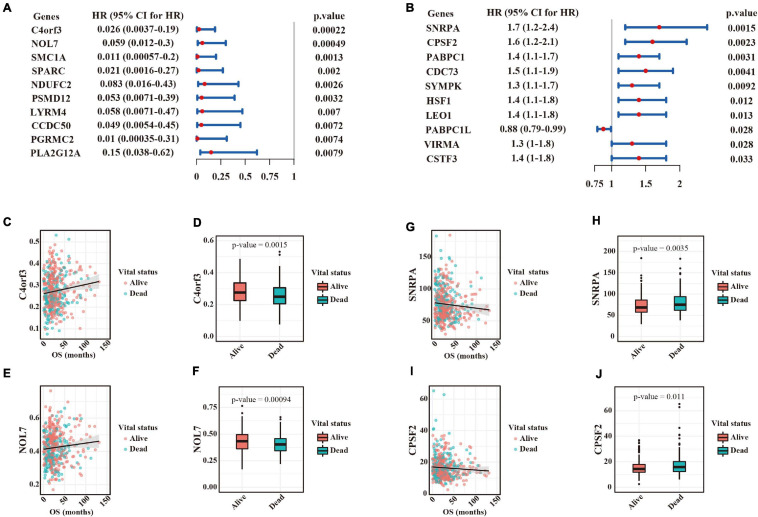
Survival-associated APA events and their regulators in LUAD. (A) Ranked list of the top ten survival-associated APA events according to the p-values calculated by the likelihood ratio test. Forest plots showing the hazard ratio and its upper and lower boundary of 95% confidence interval. Hazard ratios > 1 indicated survival risks, whereas those <1 were associated with better outcomes. (B) Ranked list of the top ten survival-associated APA regulators according to the p-values calculated by the likelihood ratio test. (C) Scatter plot of C4orf3 PDUI scores (y axis) and survival time (x axis). Each dot represents a tumor sample. (D) Comparison of C4orf3 PDUI scores between alive and dead patients. (E) Scatter plot of NOL7 expression (y axis) and survival time (x axis). (F) Comparison of NOL7 PDUI scores between alive and dead patients. (G) Scatter plot of SNRPA TPM values (y axis) and survival time (x axis). (H) Comparison of SNRPA expression between alive and dead patients. (I) Scatter plot of CPSF2 TPM values (y axis) and survival time (x axis). (J) Comparison of CPSF2 expression between alive and dead patients.